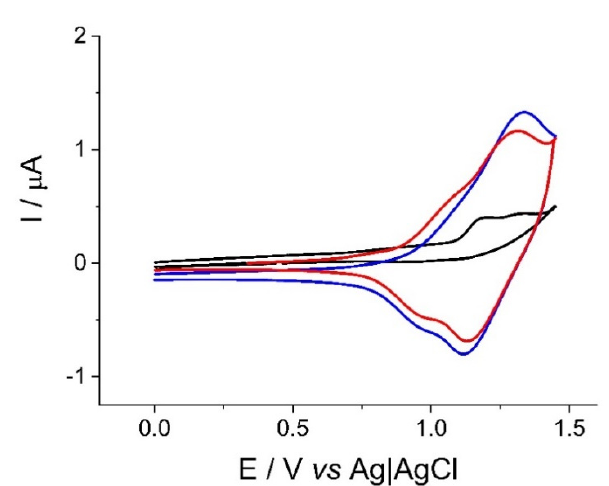
Figure 1. Cyclic voltammograms ( CVs) recorded in a 0.5 mM ( S )-BT 2 T 4 CH 3 CN solution + 0.1 M TBAPF 6 at Au disk electrode: First cycle (black line); fortieth cycle (red line). CV recorded at the oligomer-modified Au disk electrode in a ( S )-BT 2 T 4 -free CH 3 CN solution + 0.1 M TBAPF 6 (blue line).